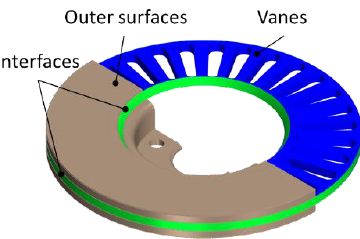
Figure 2. Rotating region inside the brake disc.